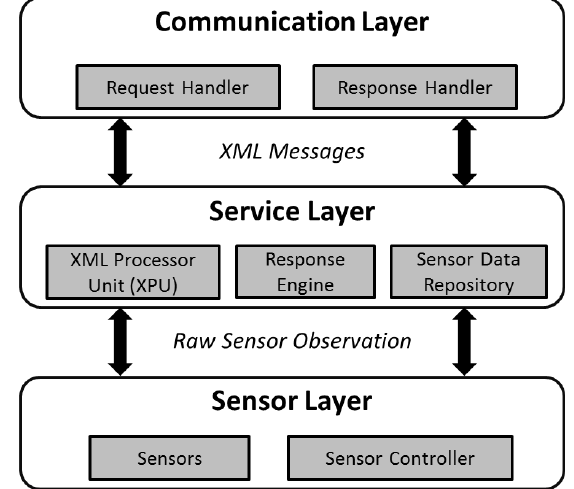
Figure 5. The system architecture supporting the TinySOS protocol